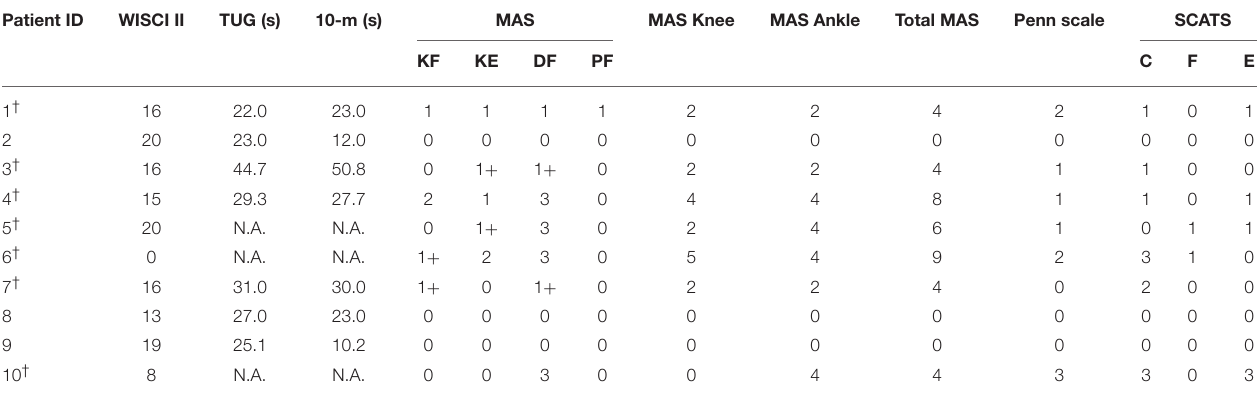
TABLE 2 | Amount of physical assistance needed, gait performance, and spasticity syndrome scores of iSCI patients. Patient